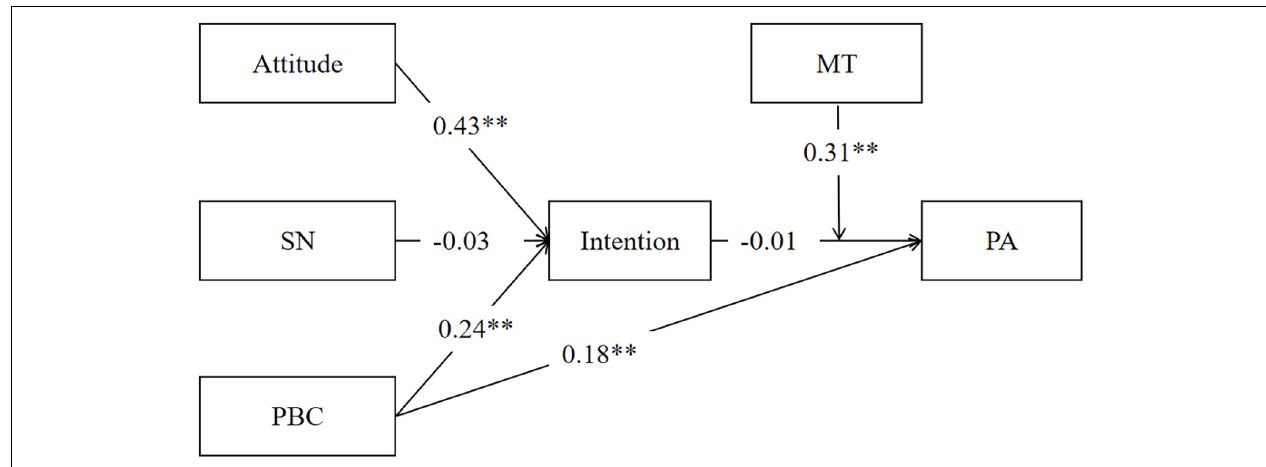
FIGURE 3 | Structural equation model of the moderation role of mental toughness on intention-behavior gap among college students. SN, subjective norm; PBC, perceived behavioral control; MT, mental toughness; PA, physical activity; * p < 0.05, ** p < 0.01.